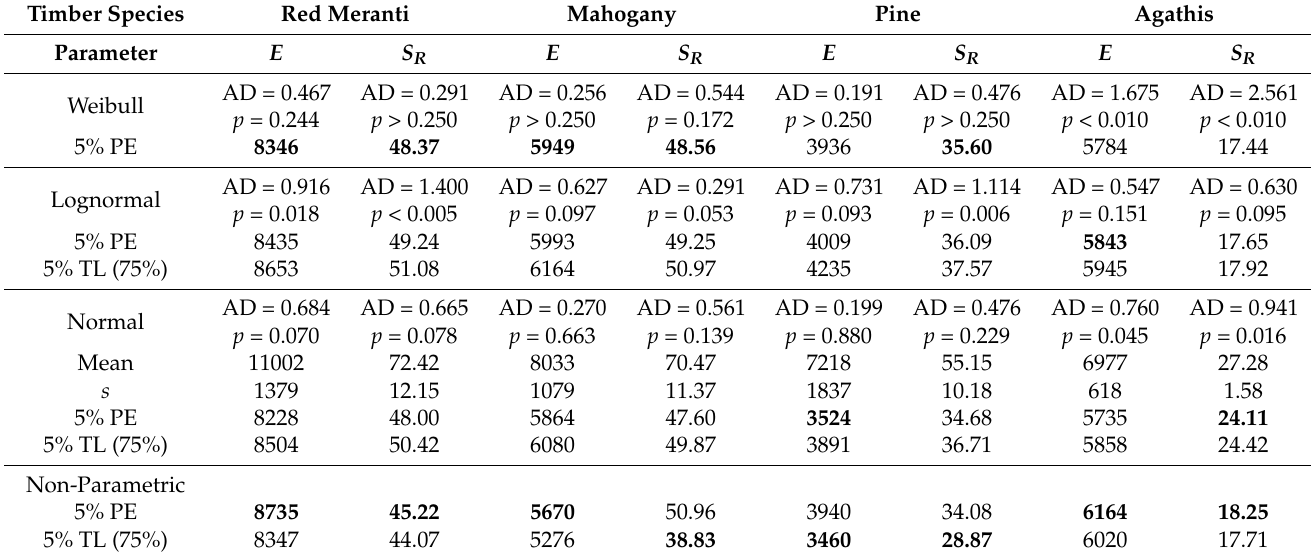
Table 4. The estimated population parameter of the small specimens’ flexural properties.